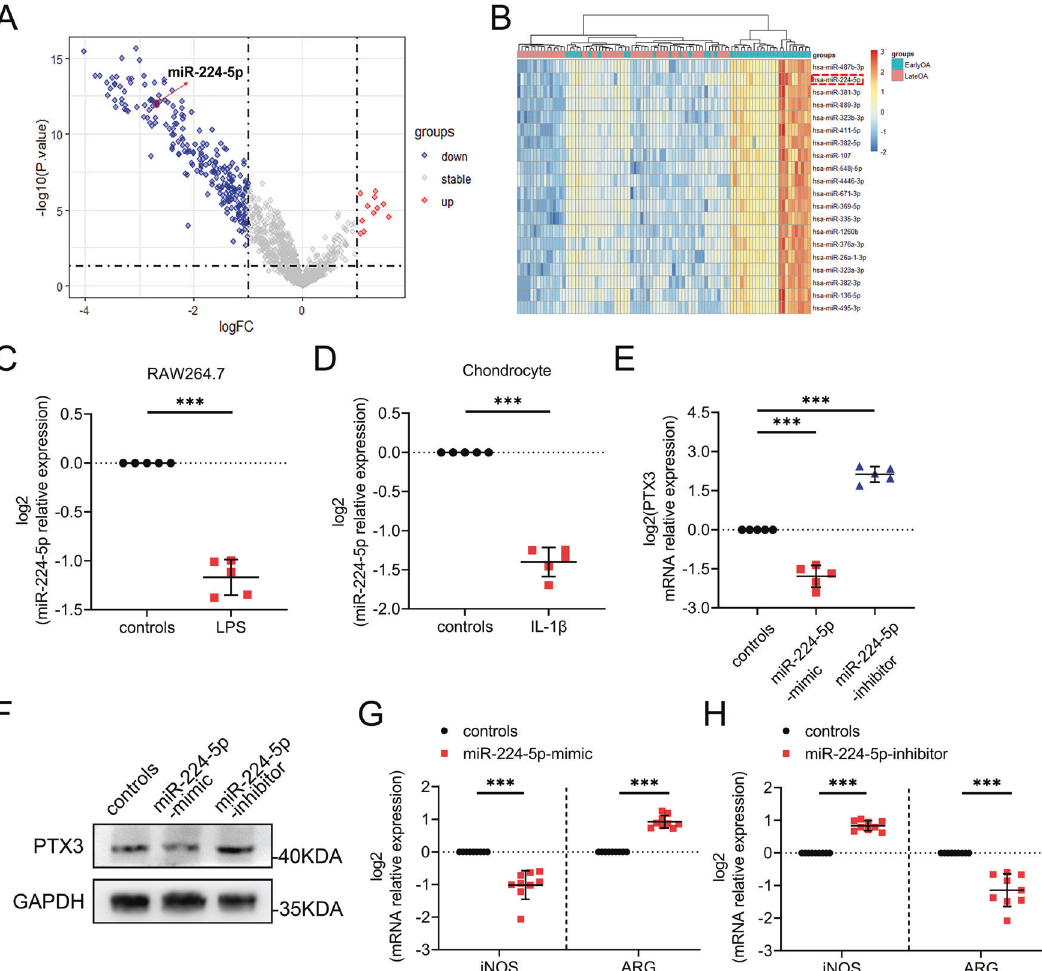
Fig. 6 MiR-224-5p regulates PTX3 during OA development. A Differentially expressed microRNAs in plasma from early and late knee OA patients based on GSE151341. B Twenty downregulated microRNAs from plasma of early and late knee OA patients based on GSE151341. C Relative mRNA expression level of miR-224 in RAW264.7 cells treated with LPS, n = 5 per group. D Relative mRNA expression level of miR-224 in primary murine chondrocytes treated with IL-1 β , n = 5 per group. E , F Relative mRNA expression levels and immunoblotting of PTX3 in miR-224-mimic- and miR-224-inhibitor-treated RAW264.7 cells. G , H Relative mRNA expression levels of iNOS and ARG in RAW264.7 cells treated with LPS, miR-224-mimic, and miR-224-inhibitor, n = 9 per group. * P <0.05, ** P <0.01, *** P <0.001, ns not signi fi cant. Data are shown as means± SD. Statistical analyses were conducted by unpaired t -test ( C , D , G , and H ) or one-way analysis of variance followed by Dunnett ’ s multiple comparison test ( E